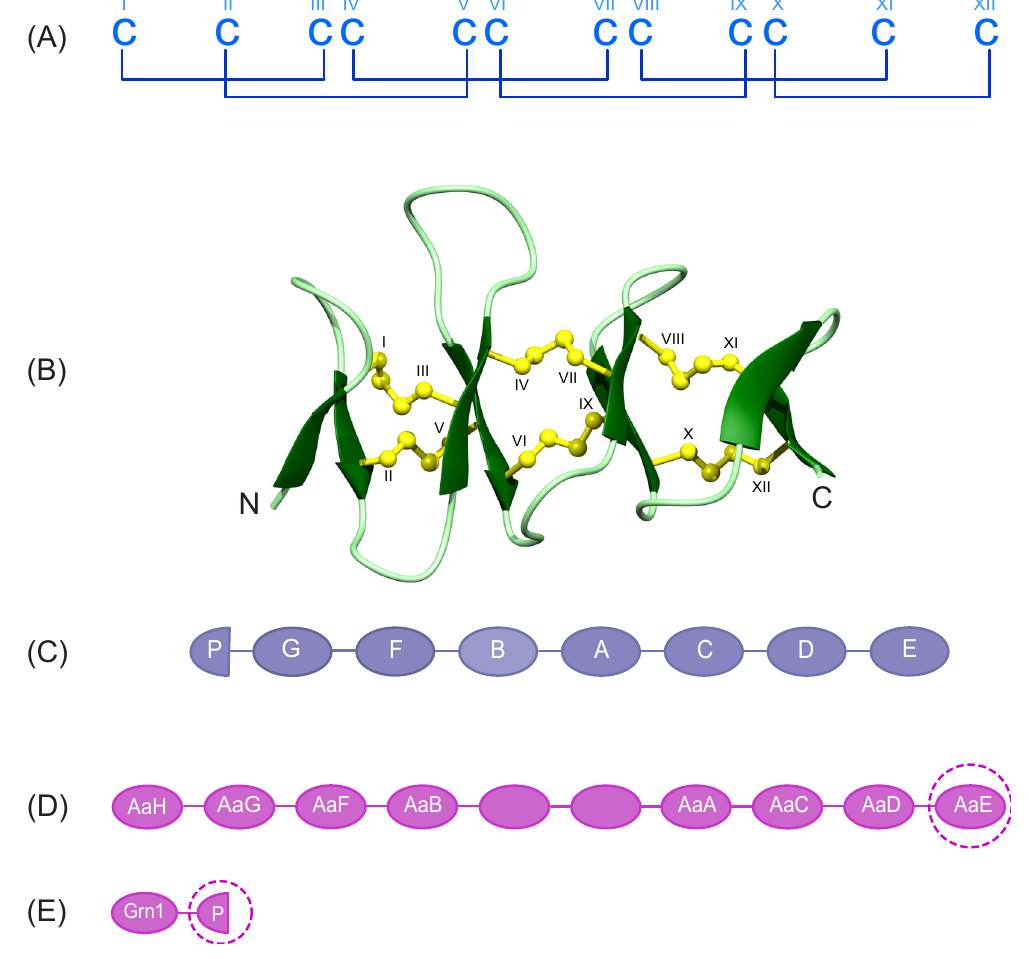
Figure 1. Granulin cysteine framework and precursor organization. ( A ) Schematic representation of the highly conserved cysteine framework and disulfide bond pairing present in the granulin family. The cysteine residues are numbered using Roman numerals (I-XII). ( Β ) The solution structure of full- length zebrafish granulin AaE (PDB ID: 6cku). Disulfide bonds are shown in yellow and cysteine residues are labelled using Roman numerals. ( C ) The order of the 7.5 granulin motifs in human progranulins, including A to G and a half-granulin motif named paragranulin (P) that includes the N-terminal six cysteines of the full length granulin. ( D ) Schematic representation of zebrafish progranulin A. Granulin modules with no label were missing from the partial clone [15]. ( E ) Granulin modules from zebrafish progranulin 1 including one full-length, and a half-granulin module named paragranulin (P) that comprises six cysteines of the full length granulin [15]. Target peptides of interest in the current study are shown with dashed circles.